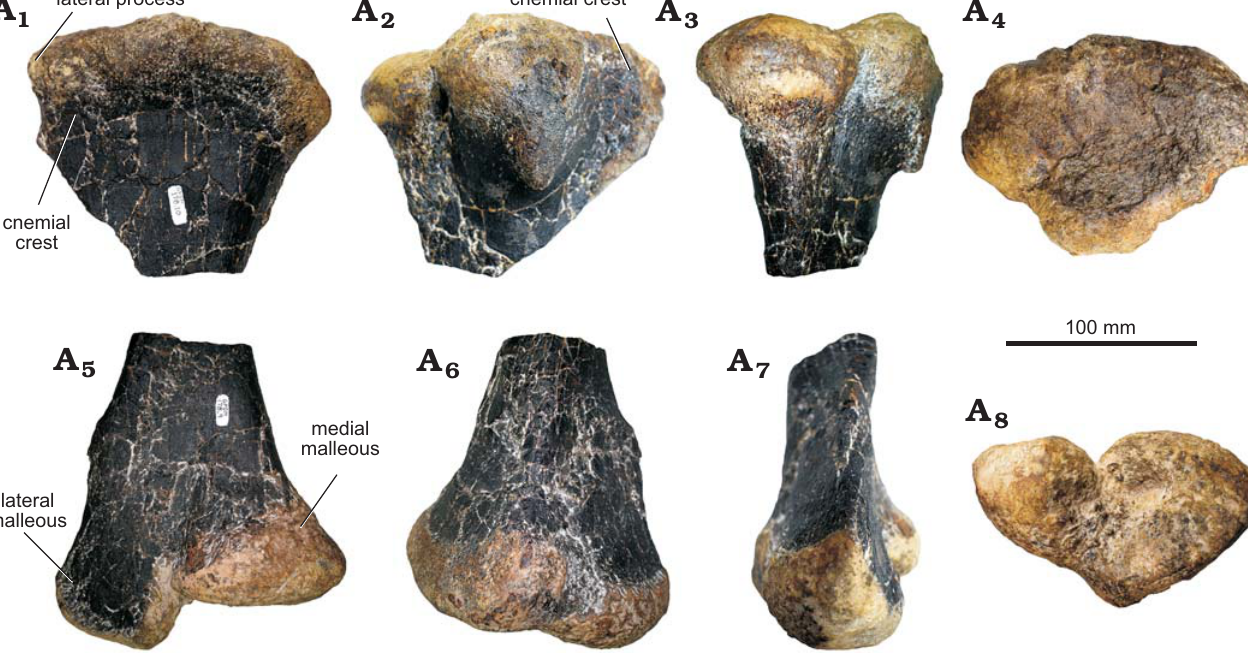
Fig. 18. Partial right tibia of stegosaur GPDM 178, near Giffen, Cascade County, Montana; in medial (A 1 , A 6 ), lateral (A 2 , A 7 ), anterior (A 3 , A 5 ), dorsal (A 4 ), and ventral (A 8 ) views. A 1 –A 4 , proximal end, A 5 –A 8 , distal